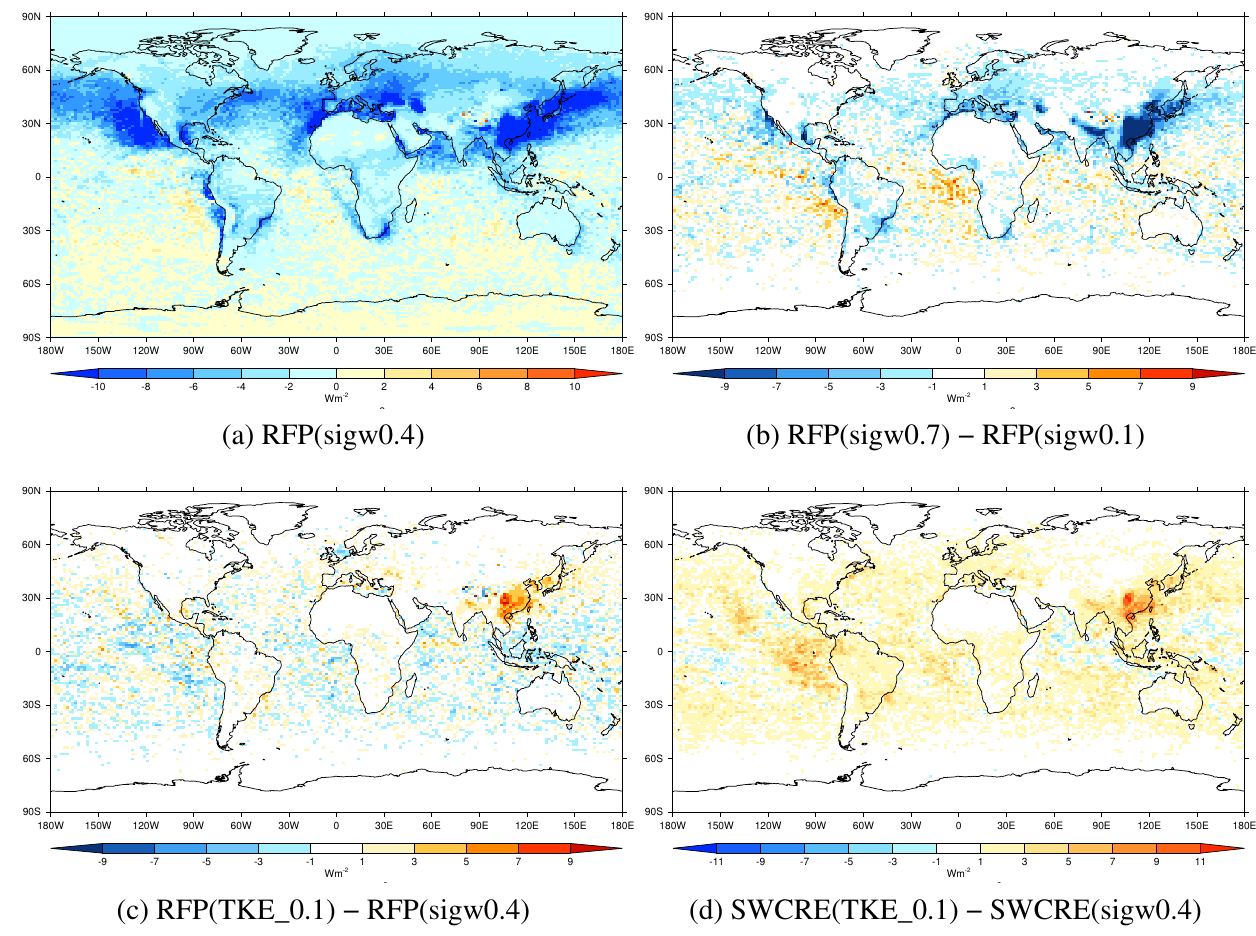
Figure 9. Annual mean radiative flux perturbations due to total (direct and indirect) anthropogenic aerosol effects for (a) model sigw0.4 (AWM = − 2 . 25Wm − 2 ). (b) and (c) show differences in annual mean radiative flux perturbations between (b) sigw0.7 − sigw0.1 (AWM = − 0 . 39Wm − 2 ), and (c) TKE_0.1 − sigw0.4 (AWM = 0 . 12Wm − 2 ). (d) shows difference in SW CRE for TKE_0.1 − sigw0.4 (AWM = 1 . 18Wm − 2 ).